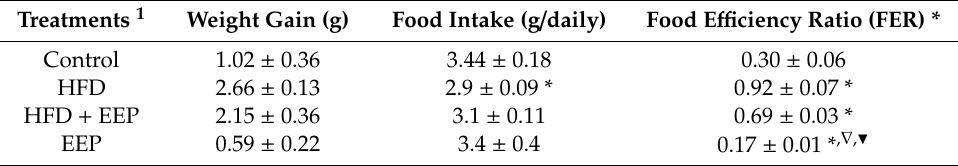
Table 3. Weight gain, food intake, food efficiency ratio (FER) in HFD fed mice. Treatments 1